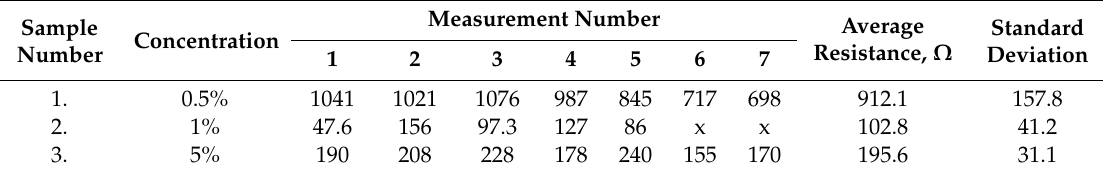
Table 10. Collection of electrical resistance values for sample C-S 3 GO, depending on the amount of cross-linking agent, hydrazine.